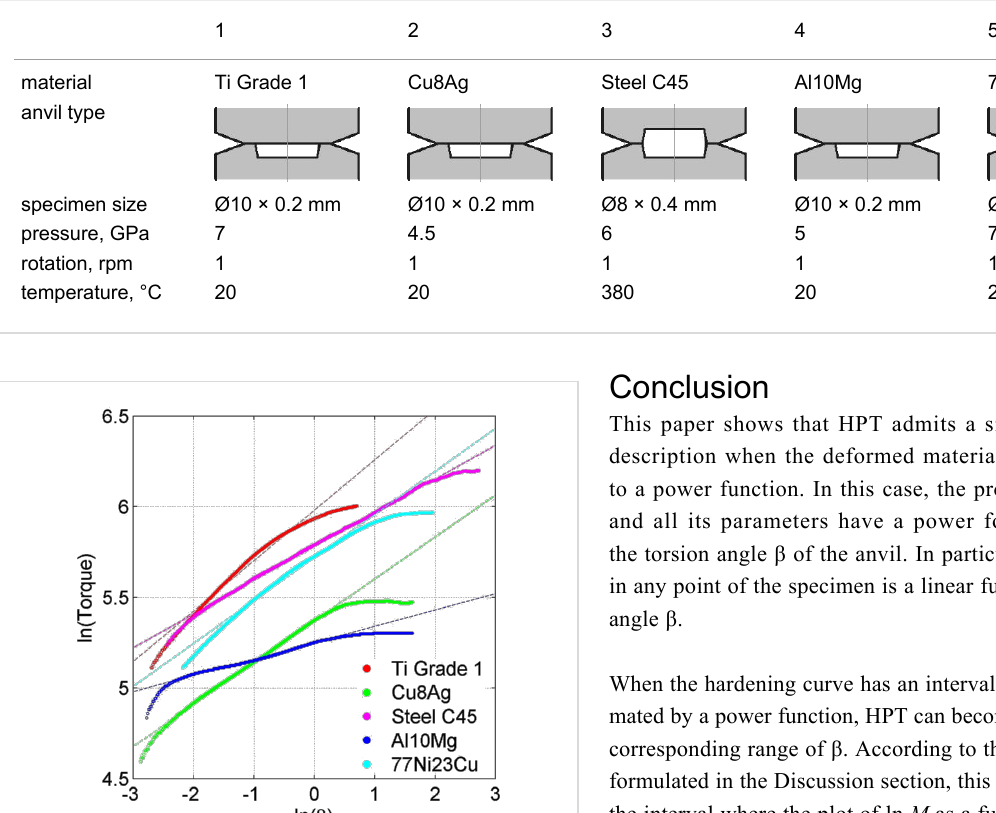
Here Φ ( r , z ) is the shear strain distribution in the specimen when β = β 0